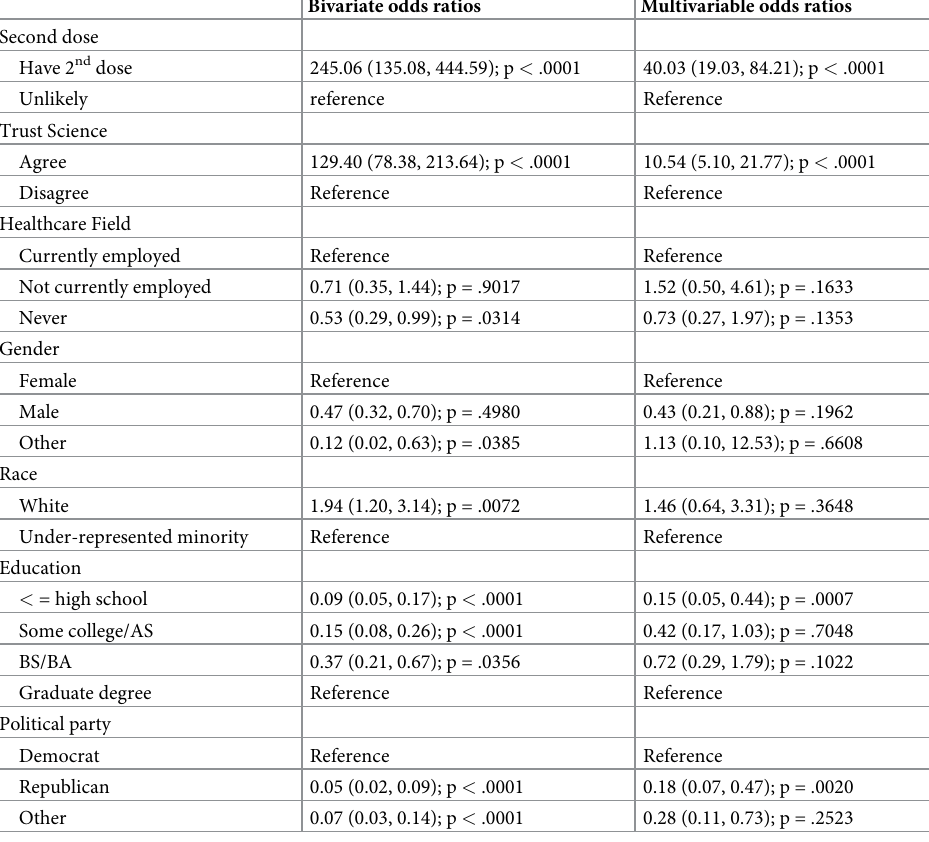
Table 2. Bivariate analysis for variables associated with perceived vaccine safety. Bivariate odds